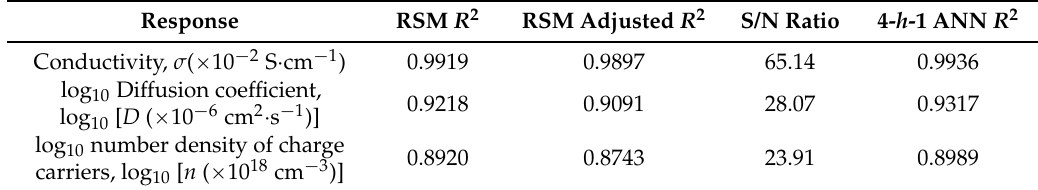
Table 2. Optimized models for each of the response properties.